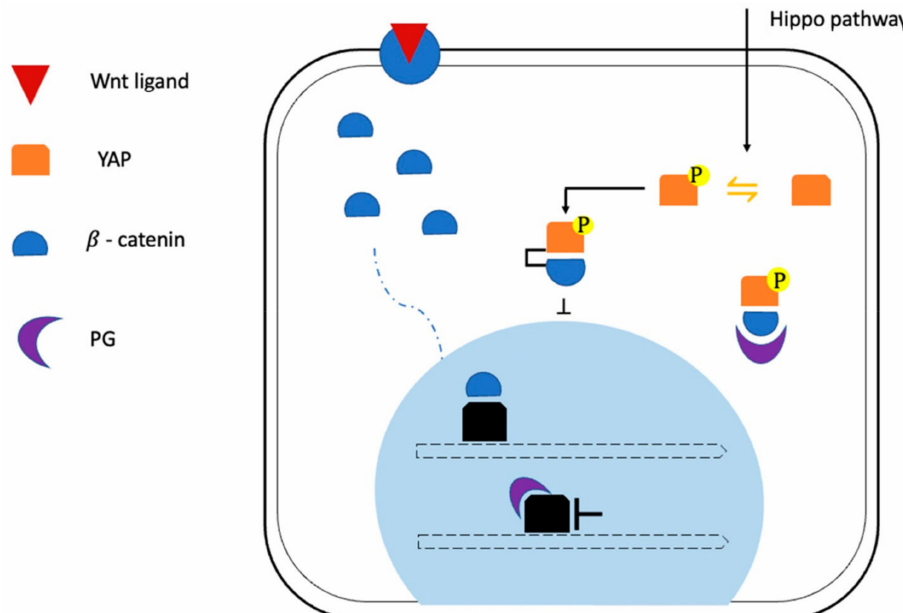
Figure 2. Hippo/YAP pathway is implicated in ACM pathogenesis. The Hippo/YAP pathway is a key regulator of organ growth that has been linked to cardiomyocyte proliferation and heart size.